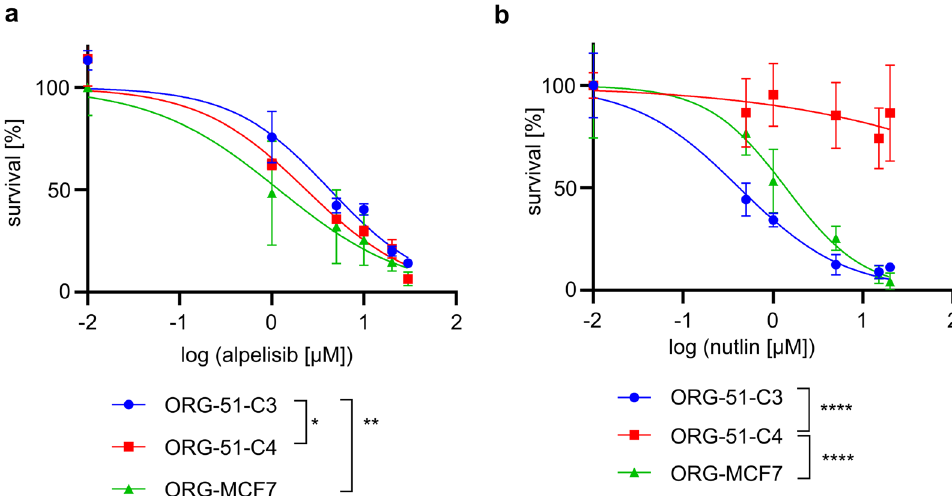
Figure 4. CMT organoids allow in vitro drug testing. ( a ) Dose–response curves indicating viability 8 days after treatment with alpelisib for PIK3CA -mutated organoid lines (ORG-51-C4, ORG-MCF7) and wild-type organoid line ORG-51-C3. Error bars represent the standard deviation (SD) of three independent experiments. P -values are calculated by one-way ANOVA followed by Tukey’s multiple comparisons test for the log(IC50) values of the survival curves, * P = 0.0363, ** P = 0.0092. As a control, the HBC PIK3CA -mutated, TP53 wild-type MCF-7 cell line was used and grown in BME to form organoids (ORG-MCF7) following the same conditions as the CMT organoids. ( b ) Dose–response curves indicating viability 8 days after treatment with nutlin-3a for TP53 -mutated organoid line ORG-51-C4 and wild-type organoid lines (ORG-51-C3, ORG-MCF7). Error bars represent SD of three independent experiments. P -values are calculated by one-way ANOVA followed by Tukey’s multiple comparisons test for the log(IC50) values of the survival curves, **** P < 0.0001. As a control, the HBC PIK3CA - mutated, TP53 wild-type MCF-7 cell line was used and grown in BME to form organoids (ORG-MCF7) following the same conditions as the CMT